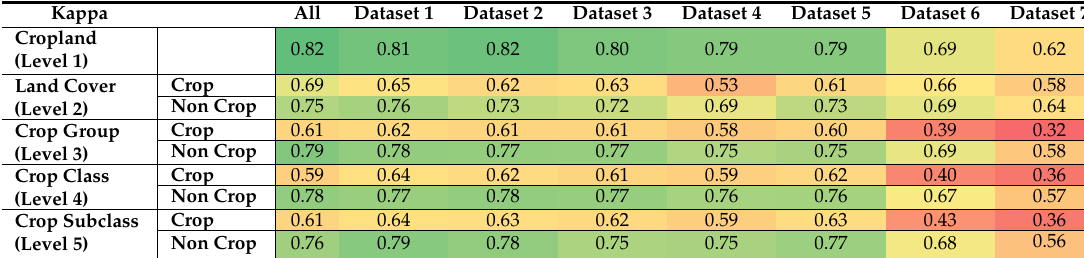
Table 7. Classification accuracy (Cohen’s Kappa) obtained from the eight datasets at each level of the nomenclature (see Table 3 for a description of the datasets). Colors along the green to red color gradient denote the accuracy of results from good to poor,